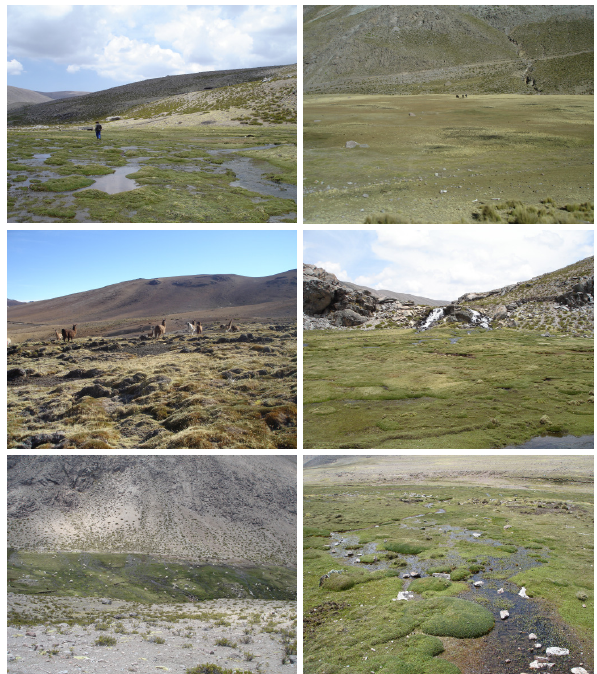
Fig. 3. Photos taken from different HAWA sites at the end of the dry season in 2006. Top left: dense cushion-plant cover of HAWA. Top right: Dried out HAWA site only containing small fractions of cushion-plant cover. Middle left: HAWA site in about 5000ma.s.l. Middle right: HAWA site containing dense cushion-plant cover right in front of a small cascade. Lower left: same site as lower right, but photographed from elevated position, note contrast be- tween dense cushion-plant cover and surrounding bare ground or shrub cover (small white dots within HAWA site indicate a grazing alpaca-herd).